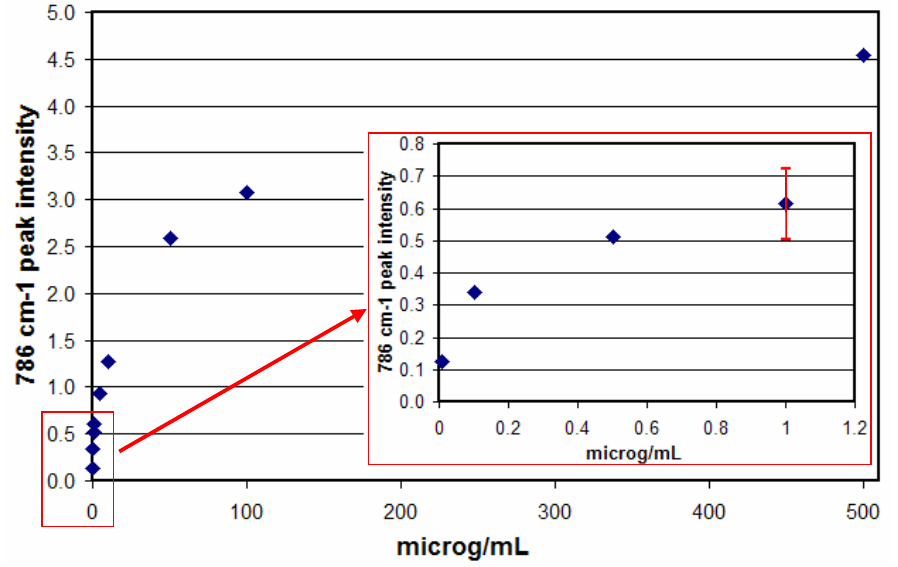
Figure 10. SER spectral response as a function of 5-FU concentration (0.01 μ g/mL is lowest point). Conditions: 100 mW of 785 nm, 3 min. Error is ~ 20% RSD, 18% shown for 1 μ g/mL.